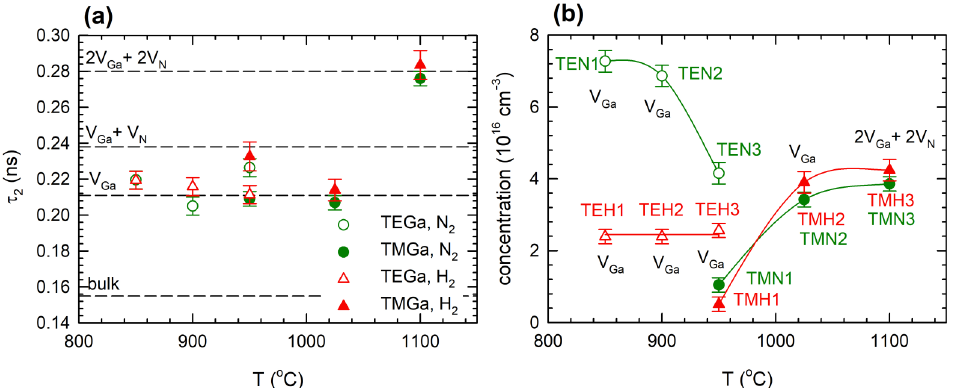
Figure 7. ( a ) The development of the lifetime τ 2 measured for the energy of incident positrons of 12